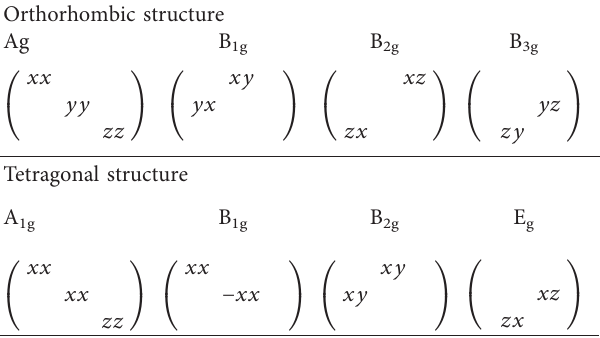
Table 1: Raman Tensor in D onal) point group